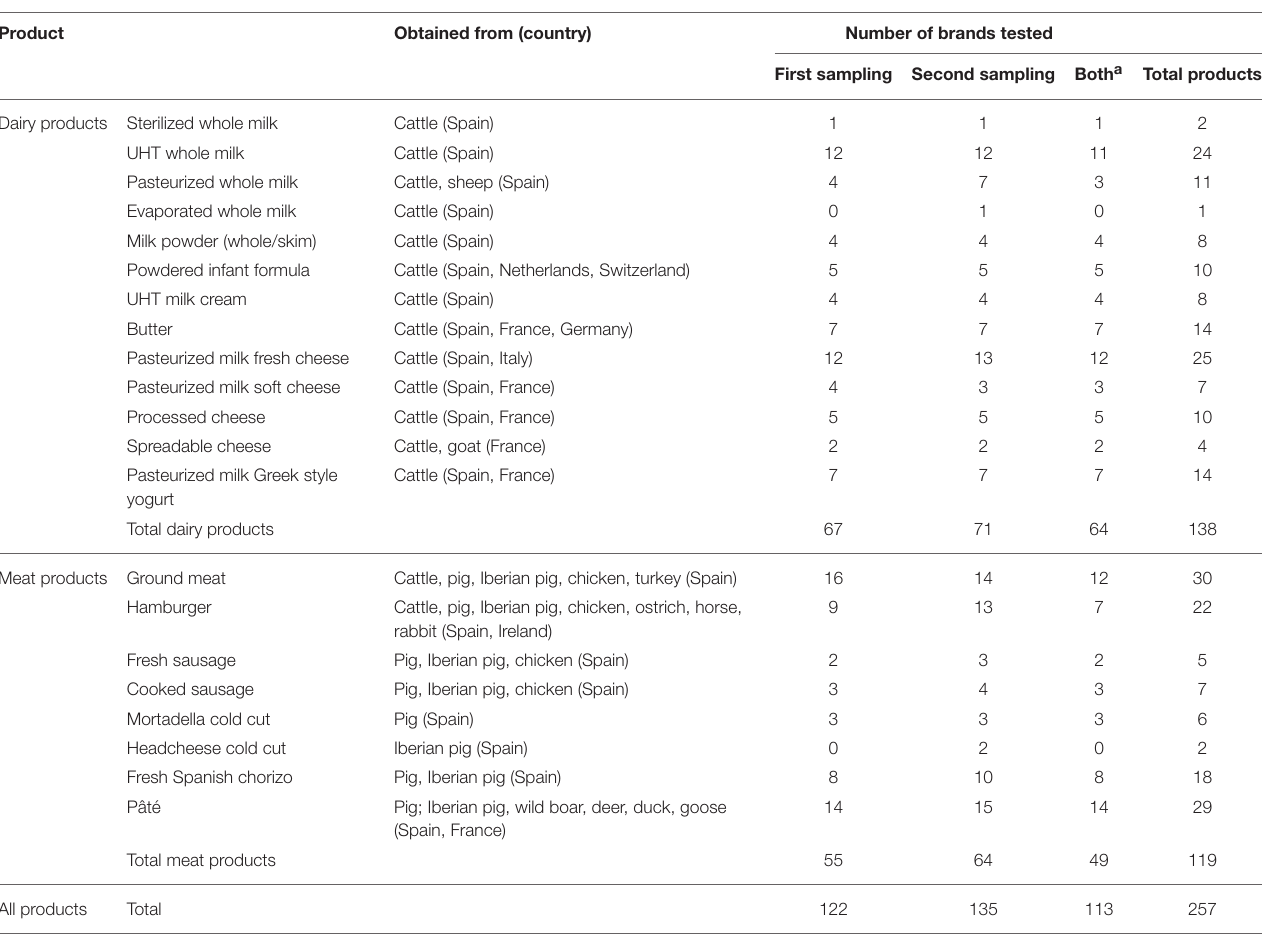
TABLE 1 | List of food types and number of brands and items analyzed.